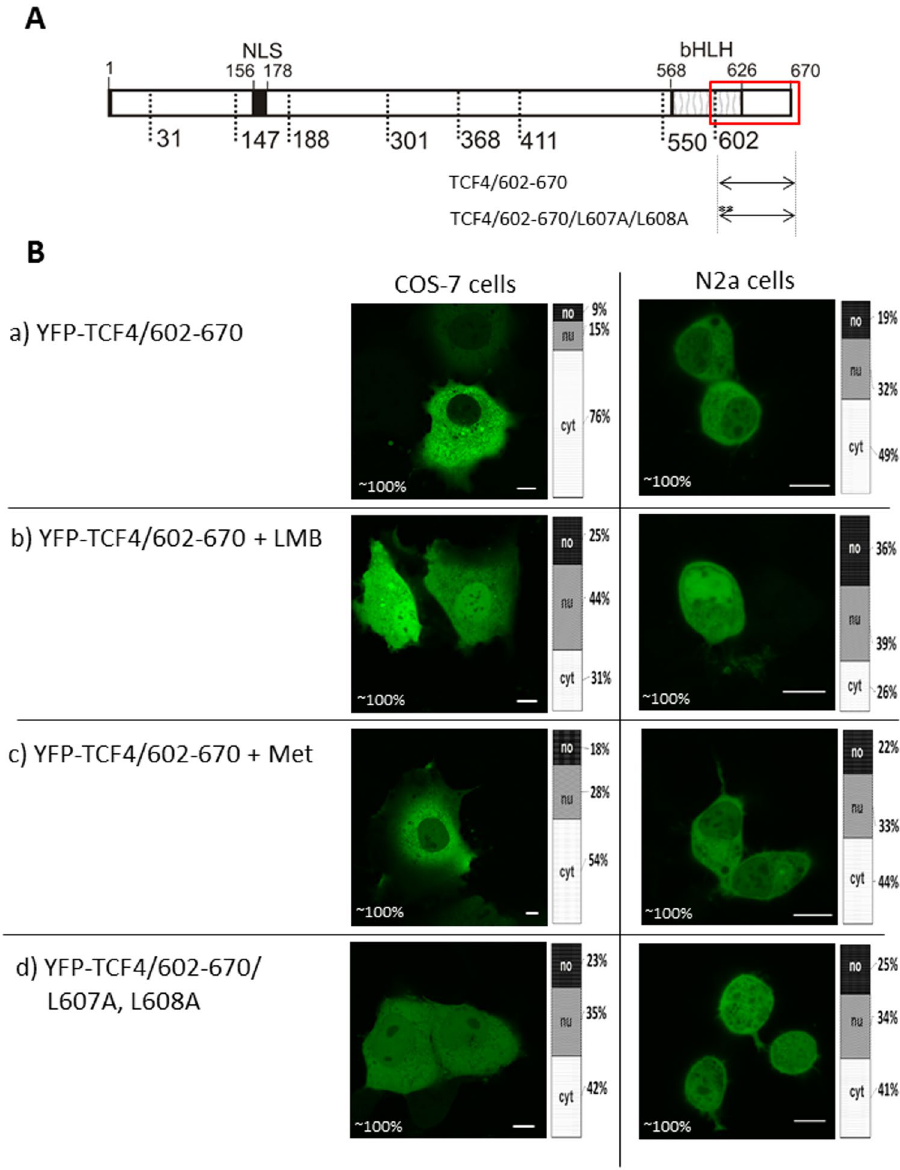
Figure 7. Subcellular distribution of the deletion mutant (602-670aa) of TCF4 ( A ) Schematic representation of TCF4 protein. Region of the studied area of TCF4 is shown by the red rectangle. Expressed deletion mutants of TCF4 are depicted as arrows. Point mutations are depicted as stars. The length of each domain in the diagram is arbitrary. ( B ) Subcellular distribution of deletion and point mutants of TCF4. Subcellular localizations of the expressed proteins were analysed by confocal microscopy 20-24 h after transfecting COS-7 and N2a cells in the absence or presence of additional factors such as LMB or methanol. Representative images (single confocal plane for confocal microscopy) of subcellular distribution of the derivatives of TCF4/602-670 area. Bar, 10 µ m. Ratios between mean fluorescence intensity in cytoplasmic, nuclear and nucleolar compartments are presented as an accumulated bar graph (no- nucleolus; nu- nucleus, cyt- cytoplasm). (a) YFP-TCF4/602-670, (b) YFP- TCF4/602-670/L607A/L608A (c) YFP-TCF4/602-670 after methanol addition, (d) YFP-TCF4/602-670 after LMB